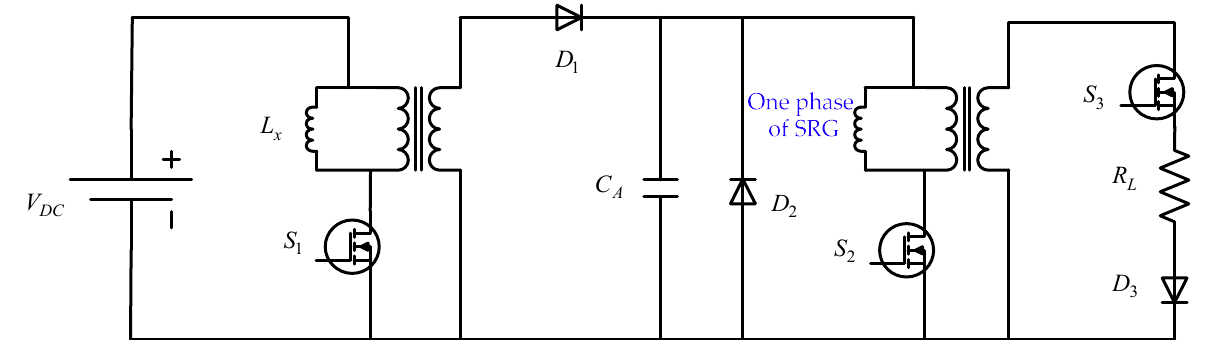
Figure 12. Accumulator capacitor converter (ACC).